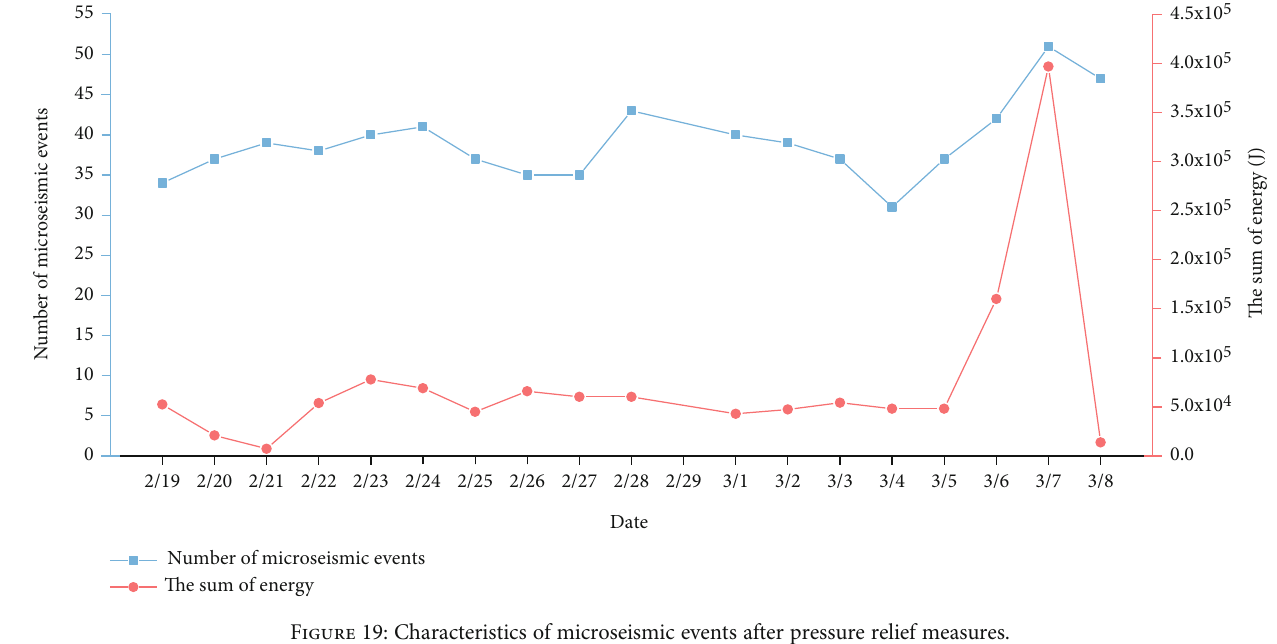
Figure 19: Characteristics of microseismic events after pressure relief measures.